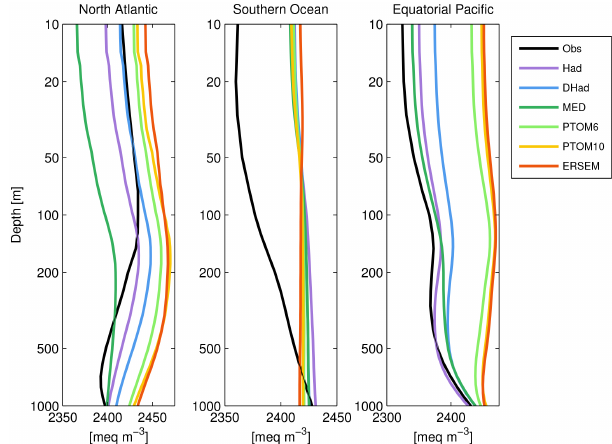
Figure 6. Observed (black; GLODAP) and modelled profiles of dis- solved inorganic carbon (mmolCm − 3 ) in the north Atlantic (0 to 60 ◦ N), Southern Ocean (90 to 60 ◦ S) and equatorial Pacific (15 ◦ S to 15 ◦ N). Vertical scaling is logarithmic (log 10 ) .